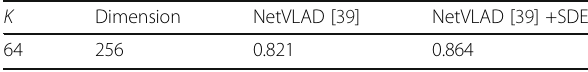
Table 7 Result of NetVLAD [39]+SDE on Holidays